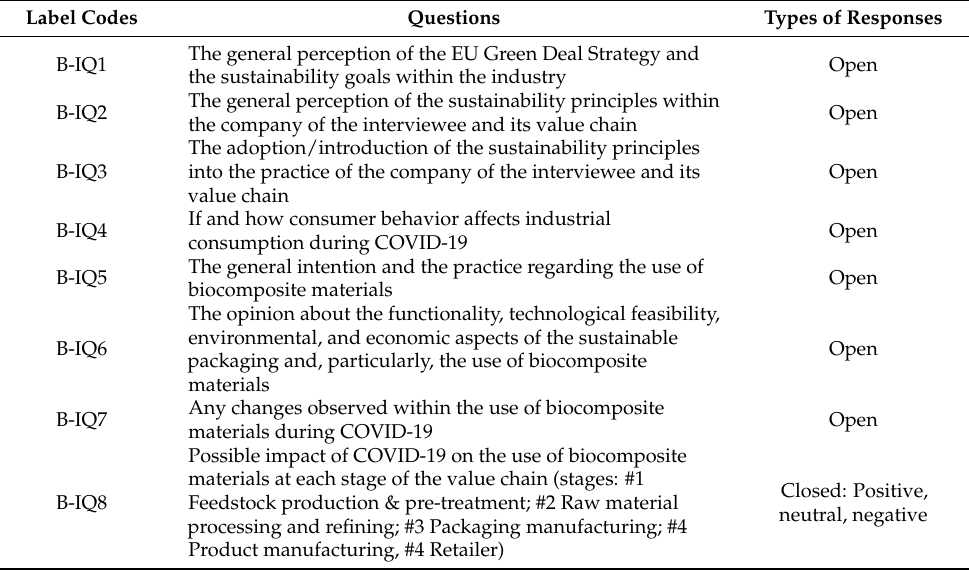
Table 3. The structure of the questions of interviews—Part: B—Main